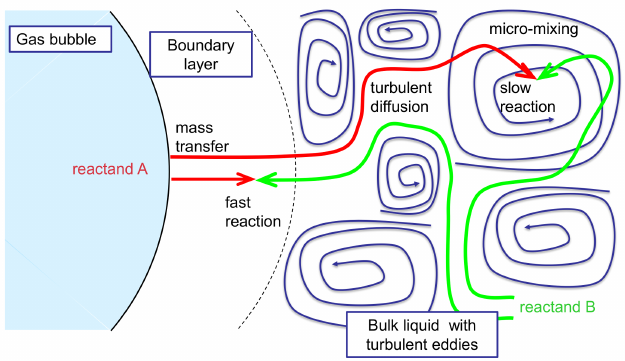
Figure 2. The main processes involved in the reactive mass transfer